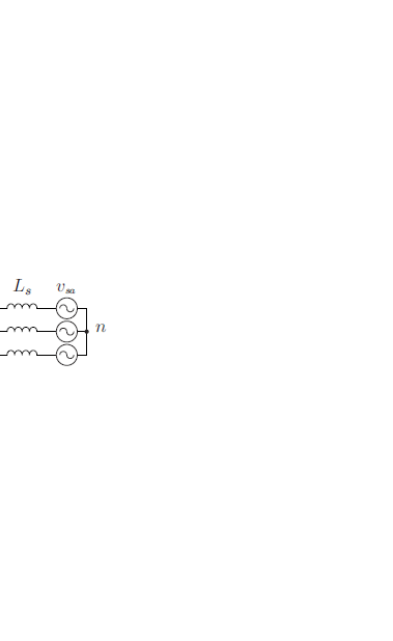
Figure 14. Modular multilevel converter for large-scale multi-string photovoltaic energy conversion system [33].